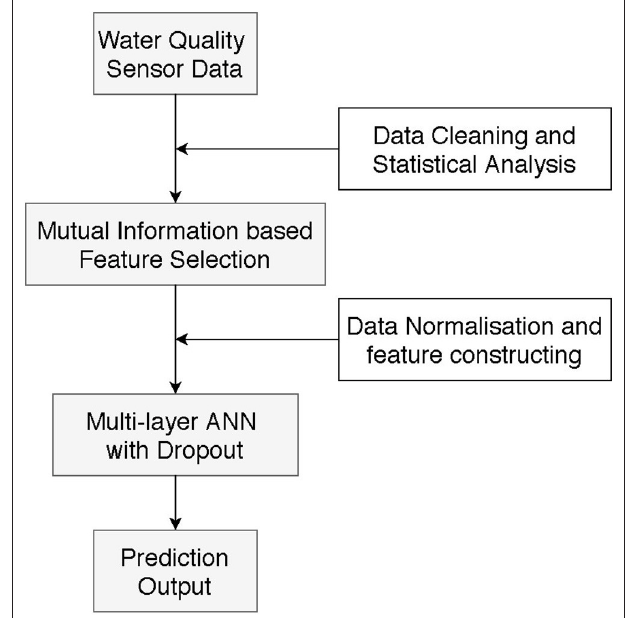
FIGURE 6 | Water quality prediction model proposed in this paper.